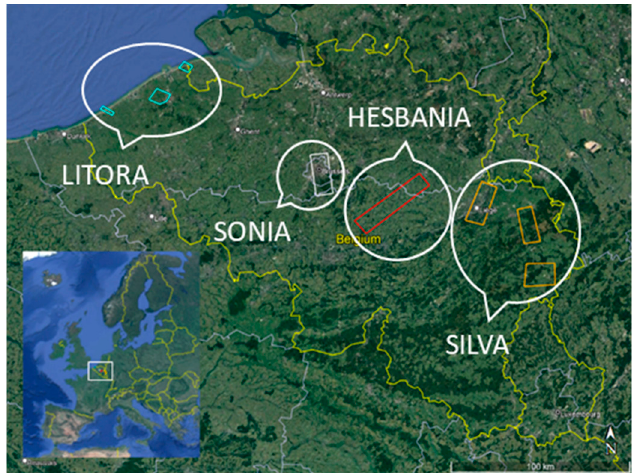
Figure 1. BELAIR sites in Belgium. The HESBANIA (agriculture) and SONIA (urban) sites are used as case studies in this research.